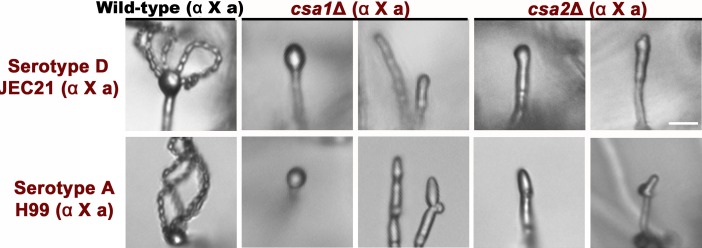
Deletion of CSA1 and CSA2 blocked bisexual sporulation in both laboratory serotype D strain (JEC21) and clinical serotype A isolate (H99).Bisexual wild type crosses (JEC21 α ×JEC20 a) and bilateral mutant crosses (csa1Δα ×csa1Δa, csa2Δα ×csa2Δa) were conducted on V8 medium in the dark at 25°C to stimulate matings. Sporulation phenotypes were photographed at 7 days (serotype D) or 1 month (serotype A) after mating stimulation. Scale bar = 10 μm.